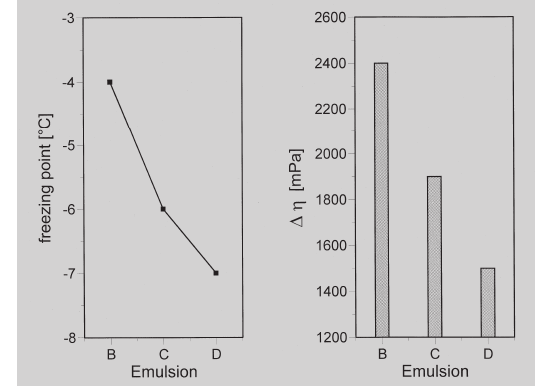
Figure 7: Comparison of rheological freezing points with viscosity increases after storage at –10°C for o/w emulsions B, C and